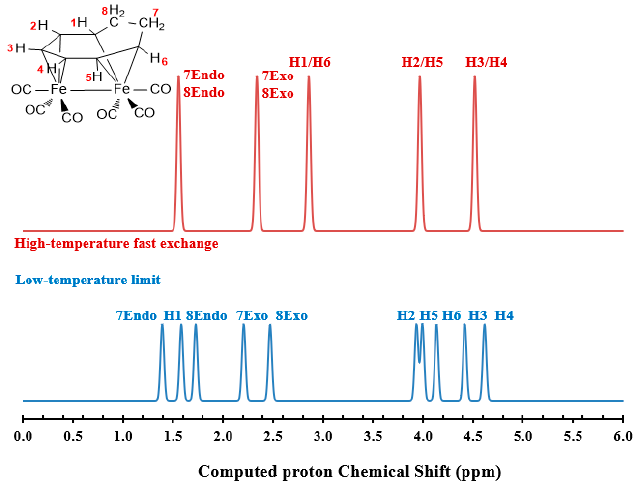
Figure 4. Simulated gas phase 1 H-NMR spectra of (C 8 H 10 )Fe 2 (CO) 6 at the low-temperature limit (bottom, blue) and high-temperature fast exchange (top, red).